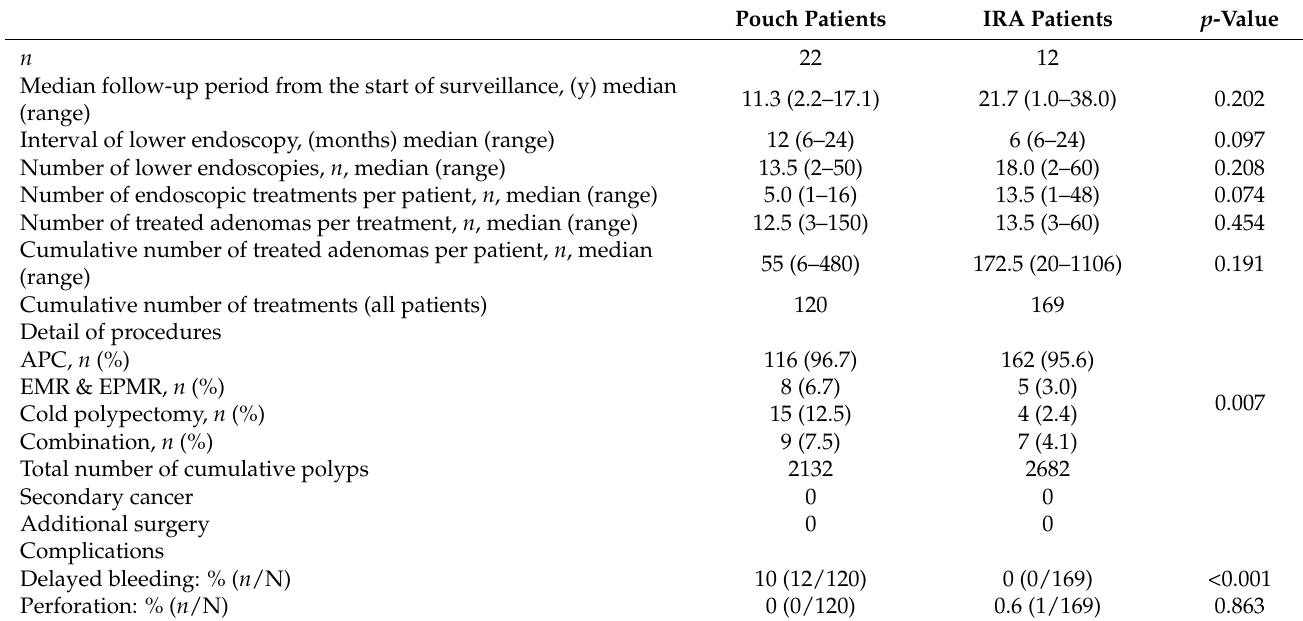
Table 2. Clinical outcomes of endoscopic